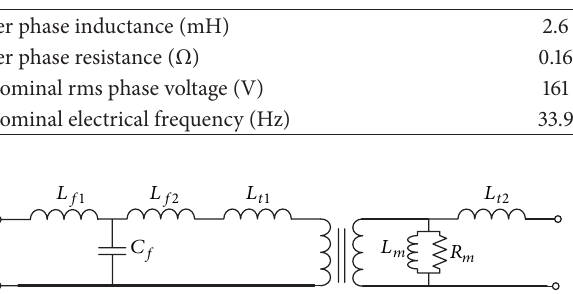
Table 3: Filter and tap transformer values. Table 4: Relevant generator parameters.